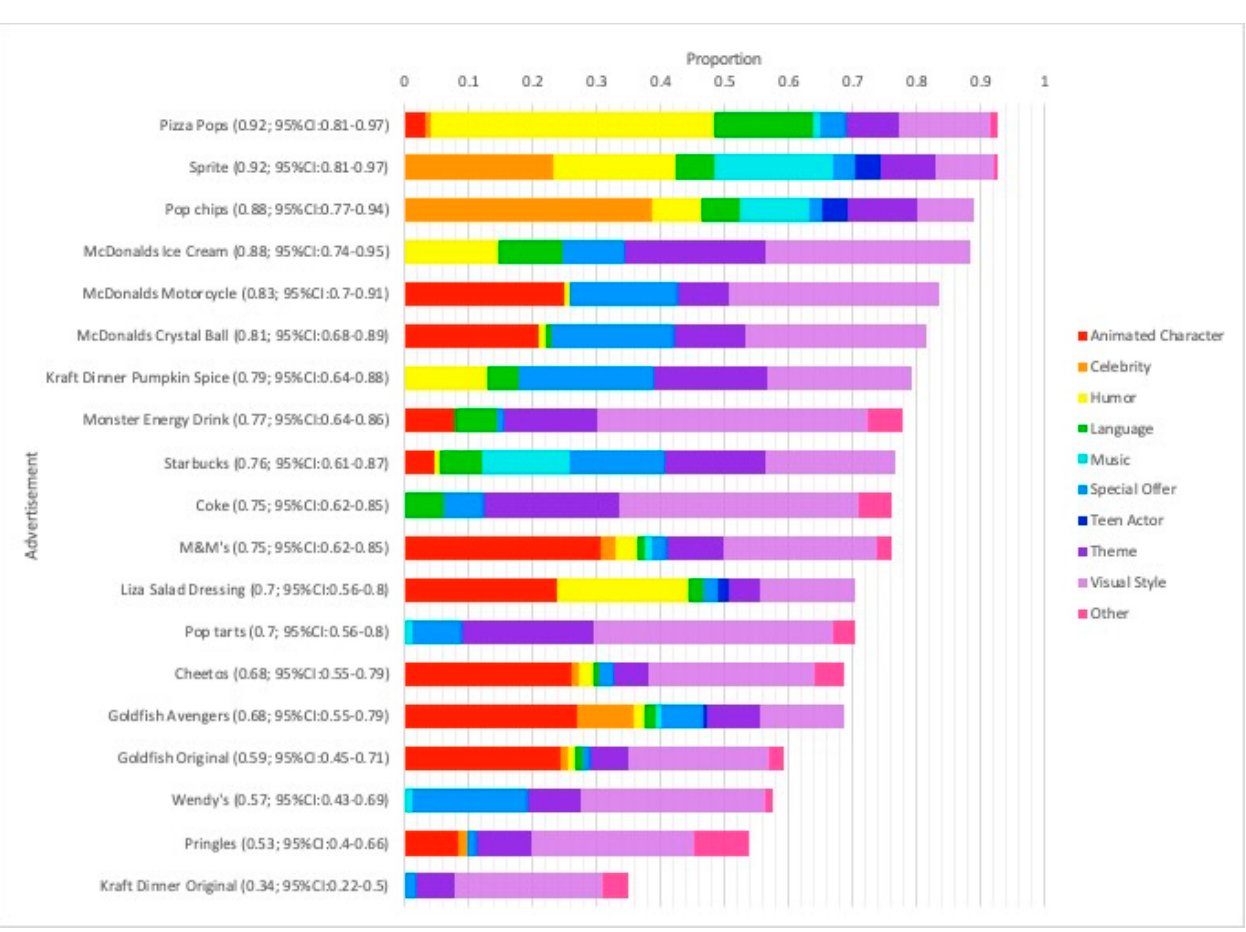
Figure 1. Stacked bar graph showing the relative contribution of each tag to the proportion of indicators for identifying an instance of teen ‐ targeted food marketing.